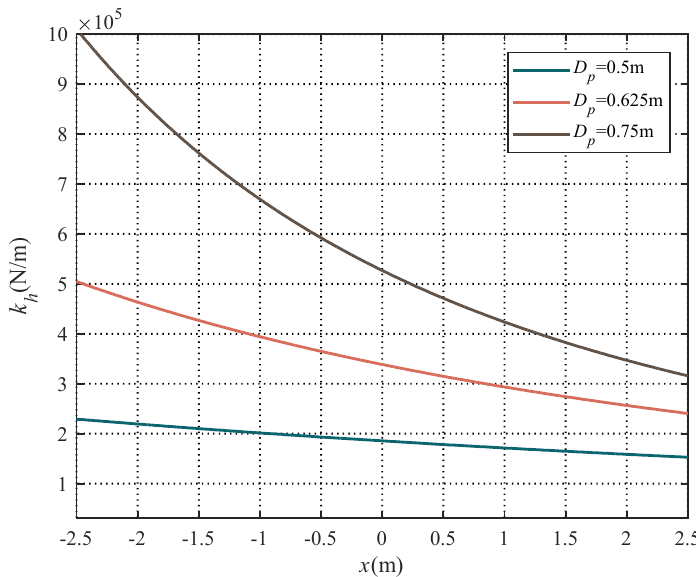
Figure 7. Effect of piston diameter on stiffness ( V c 0 = 4 m 3 , D r = 0.28 m).